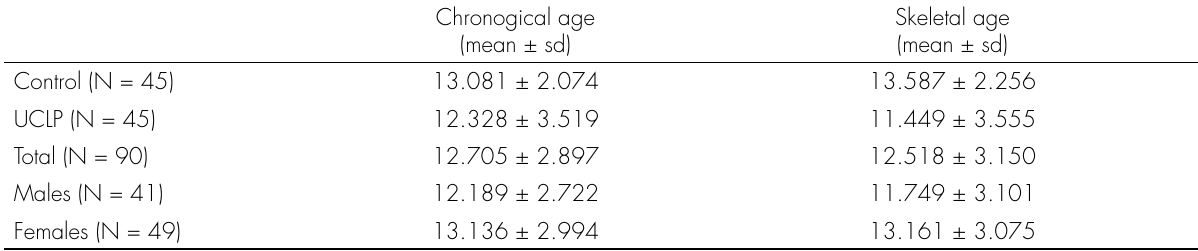
Table I. Comparison of chronological and skeletal ages in the overall study